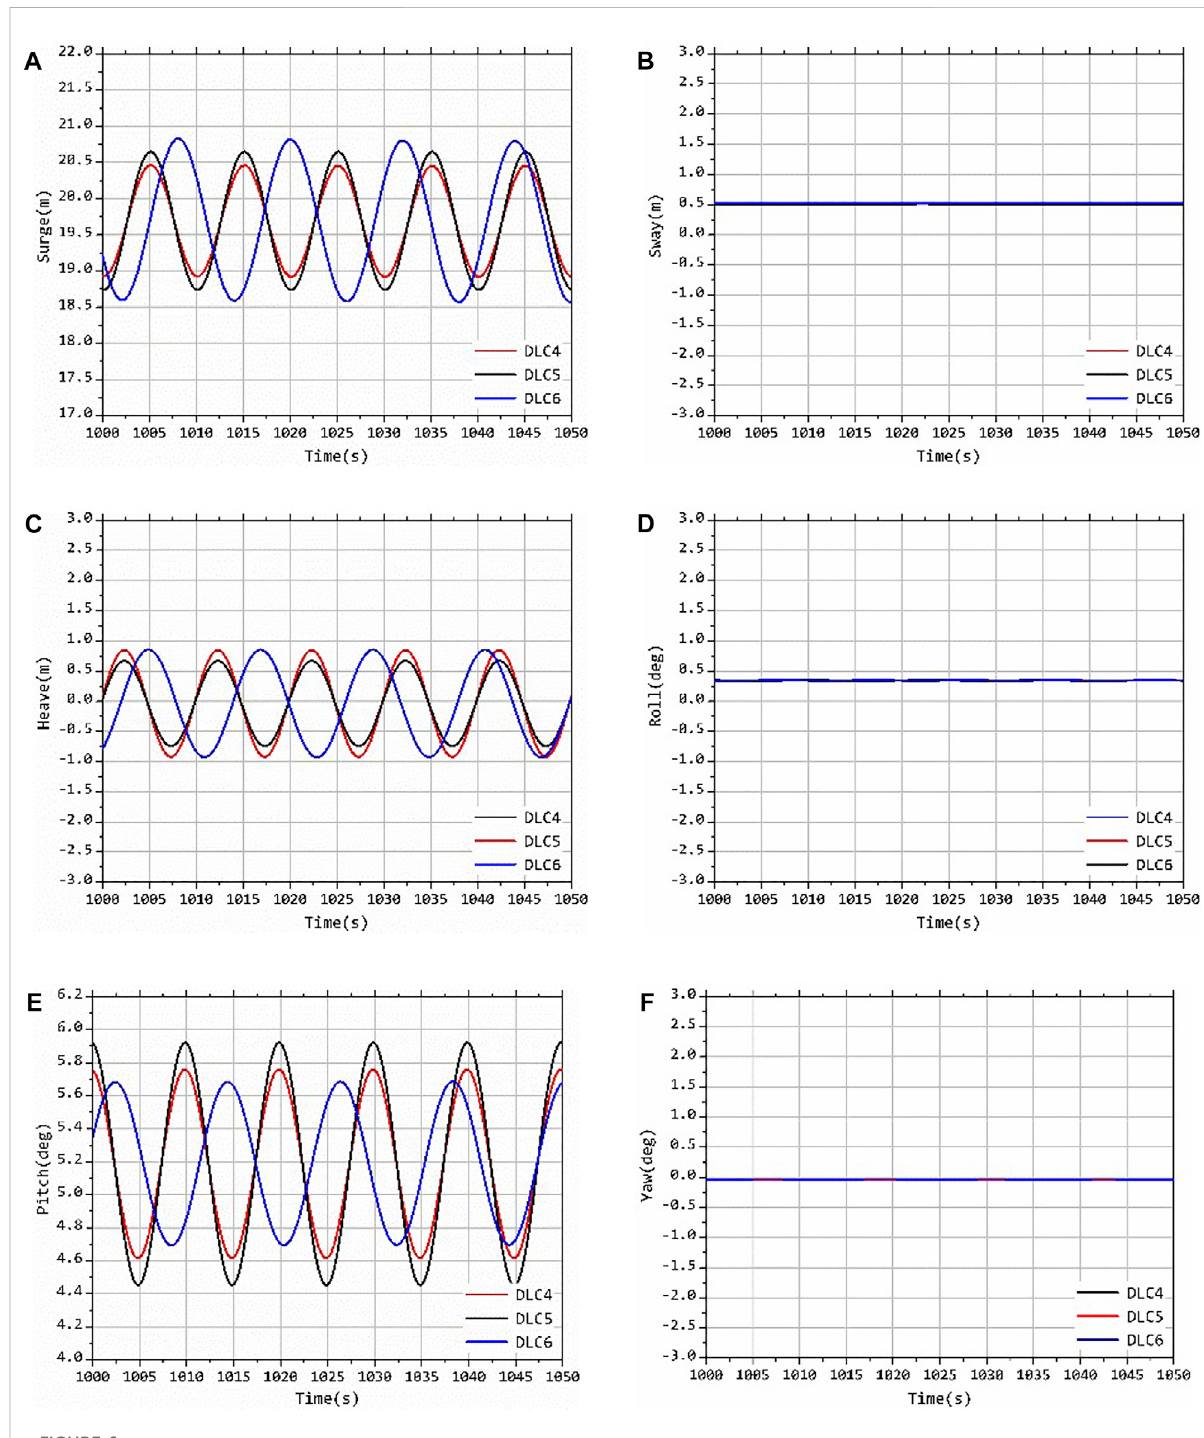
FIGURE 6 Motions of the platform under the regular wave: (A) Surge; (B) Sway; (C) Heave; (D) Roll; (E) pitch; (F)